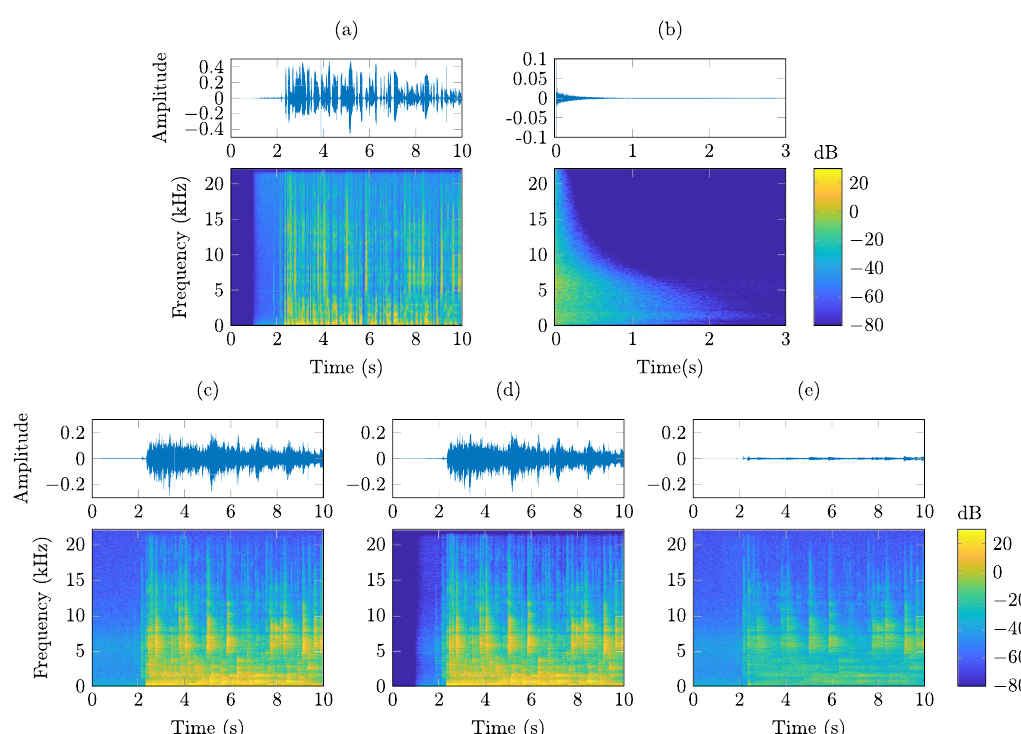
Fig. 9 Waveform and corresponding spectrogram of signals related to the SAL recordings. a First 10 seconds of the source signal corresponding to a female speaker, F1 (cf. Table 3), b computed RIR from the loudspeaker S0_1 to microphone BTELF (cf. Fig. 3), c recorded microphone BTELF signal after the signal from a was played through the loudspeaker S0_1, d simulated signal from the convolution of a and b , e error between signals c and